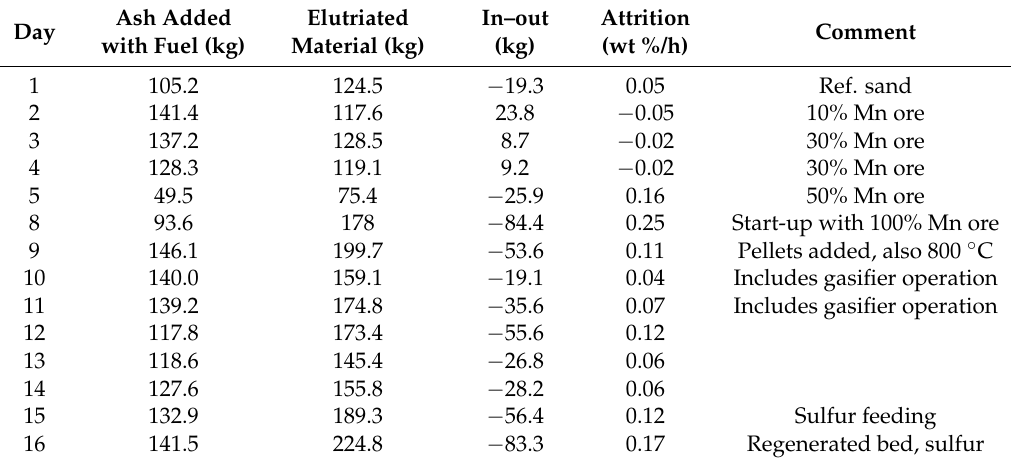
Table 5. Mass balance and estimated rate of